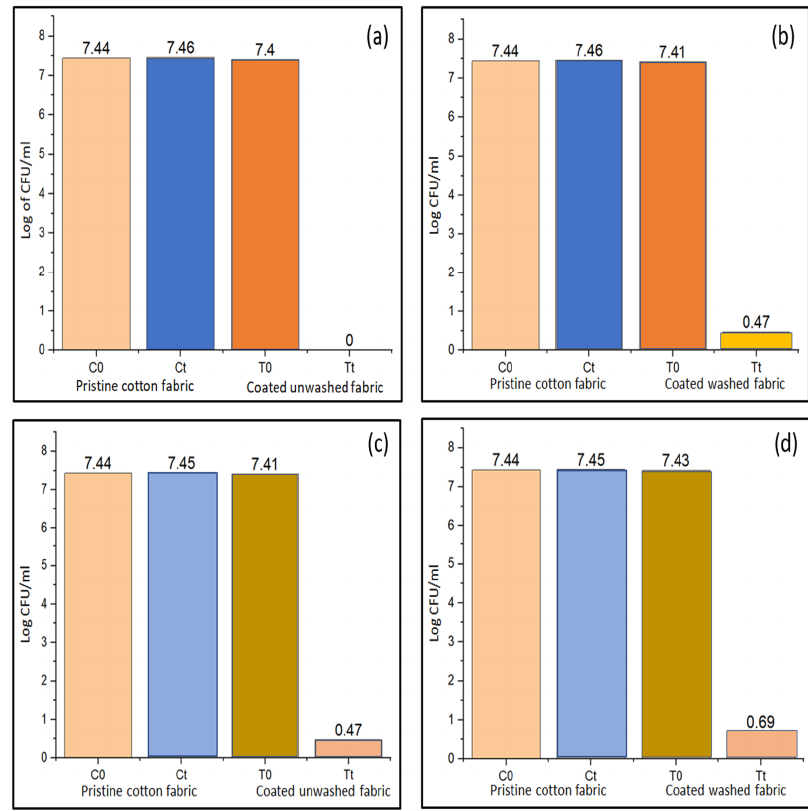
Figure 13. Antibacterial properties of ( a ) the pristine cotton fabric and coated unwashed cotton fab- ric against S. aureus , ( b ) the pristine cotton fabric and coated washed fabric after 20 washing cycles against S. aureus , ( c ) the pristine cotton fabric and coated unwashed cotton fabric against E. coli , ( d ) the pristine cotton fabric and coated washed fabric after 20 washing cycles against E. coli.